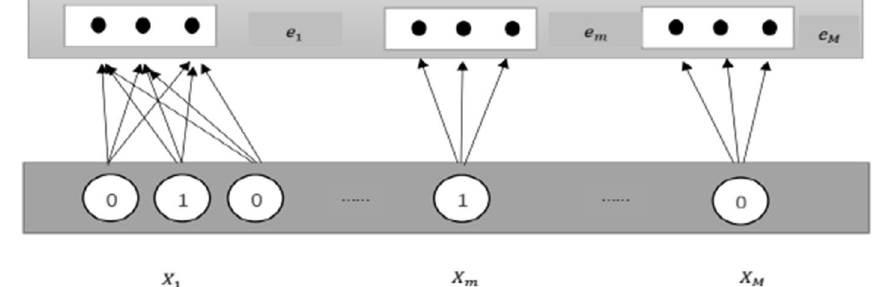
Fig. 2 Input and embedding layer illustration, with low-dimensional packed vectors representing both categorical and numerical